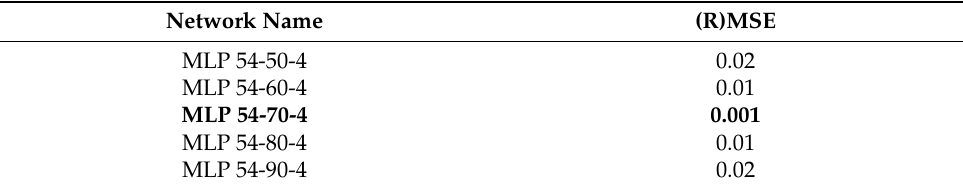
Table 8. Selected ANNs quality assessment.